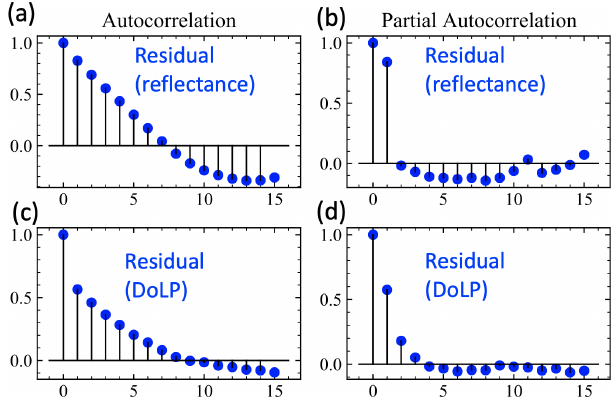
Figure 14. Autocorrelation (a, c) and partial autocorrelation (b, d) for the fitting residuals of reflectance and DoLP from Scene 3 at 670nm